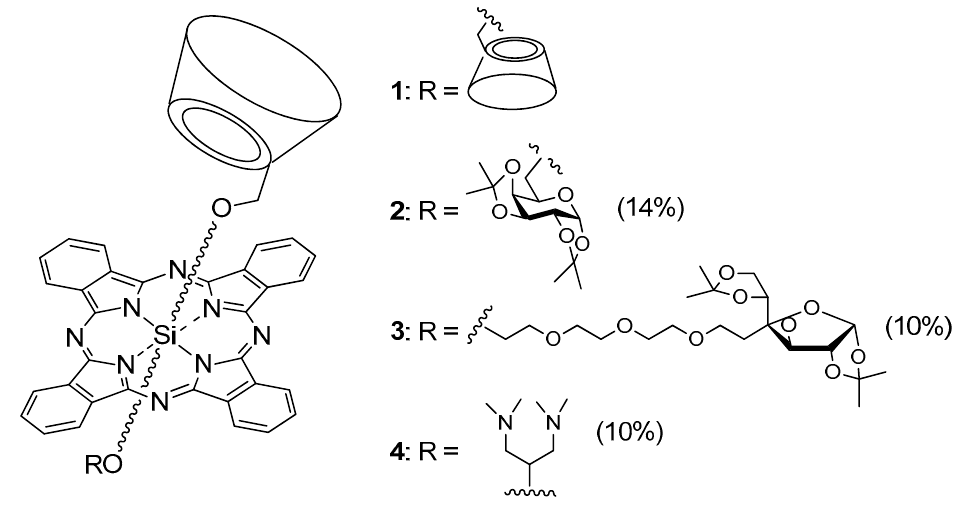
Figure 25. Chemical structure of PMe- β -CD-Si IV Pc conjugates 1 – 4 .